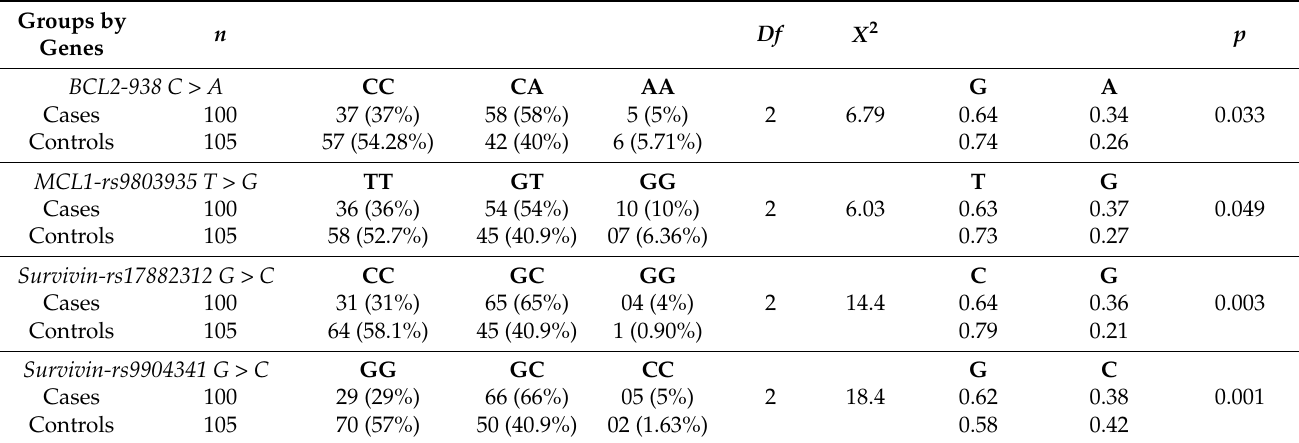
Table 3. Distribution of genes’ variation between cases and